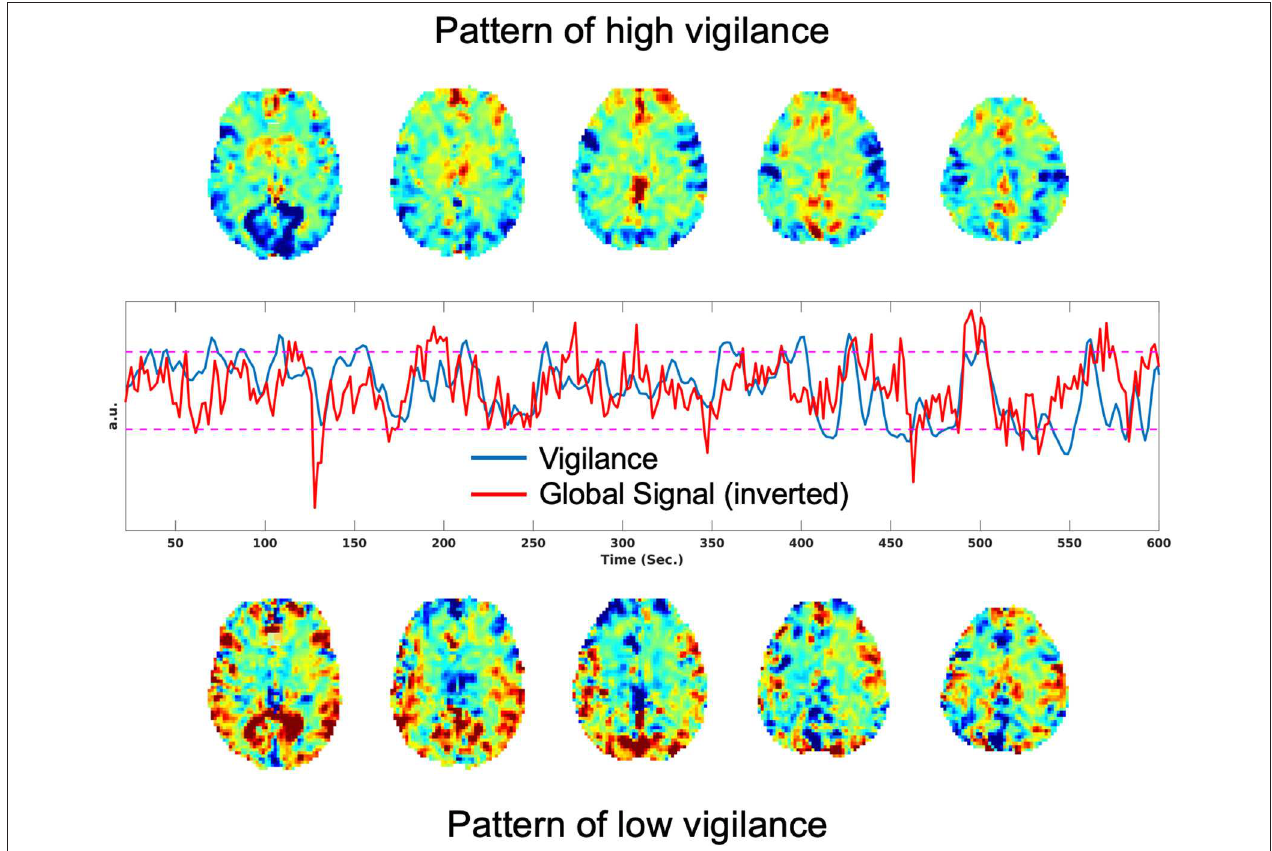
FIGURE 1 | Patterns associated with high and low vigilance and relation between vigilance and the global signal. (Top) Average rsfMRI image from the time points corresponding to the top 10% of vigilance values. (Middle) Vigilance time course in blue and the global signal (inverted for display) in red, with a correlation of r = − 0.33. (Bottom) Average rsfMRI image from the time points corresponding to the lowest 10% of vigilance